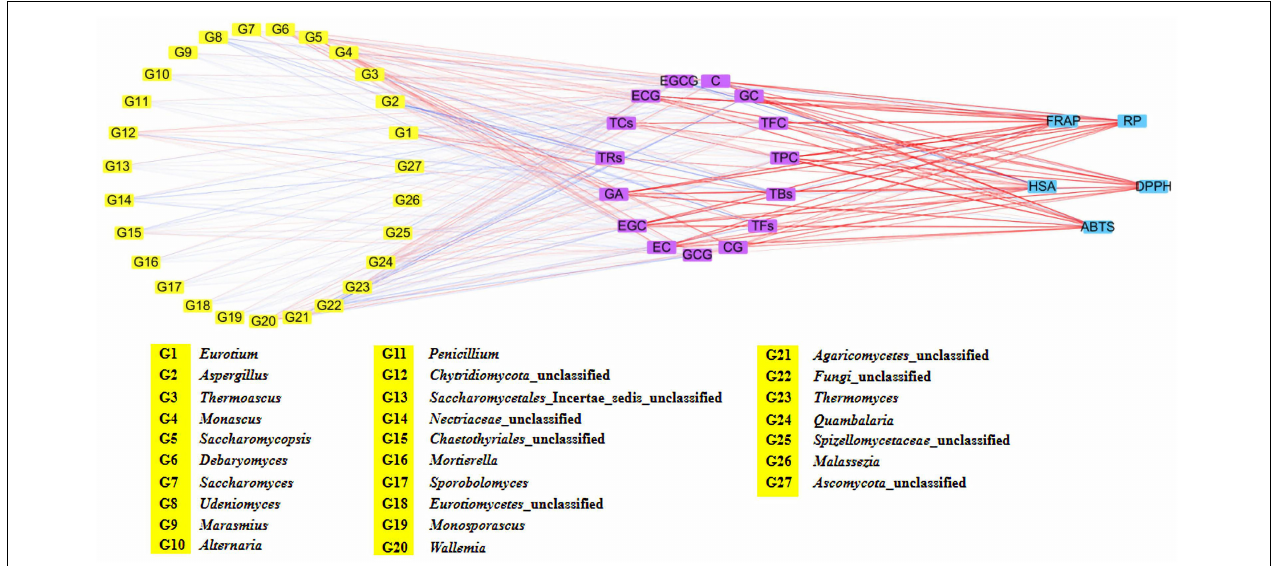
FIGURE 6 | Network visualized the relationship between main metabolites and fungal community, as well as antioxidant activity and main metabolites of five Fu brick teas in different regions. TABLE 1 | Contents of gallic acid and catechins of five Fu brick teas in different regions. Compounds Contents (mg/100